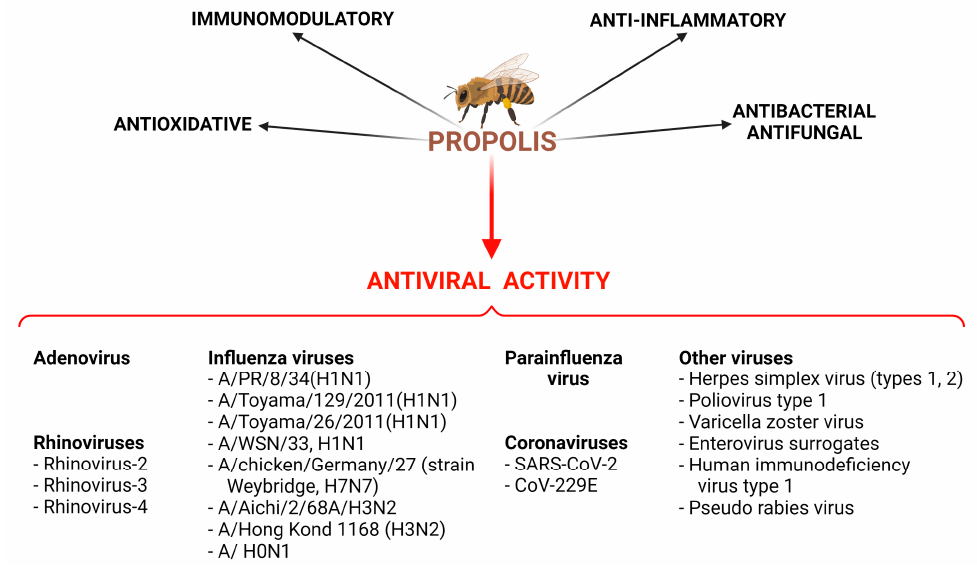
Figure 1. Activities of propolis extracts and their natural chemical compounds demonstrated during in vitro and in vivo studies. Created with BioRender.com.